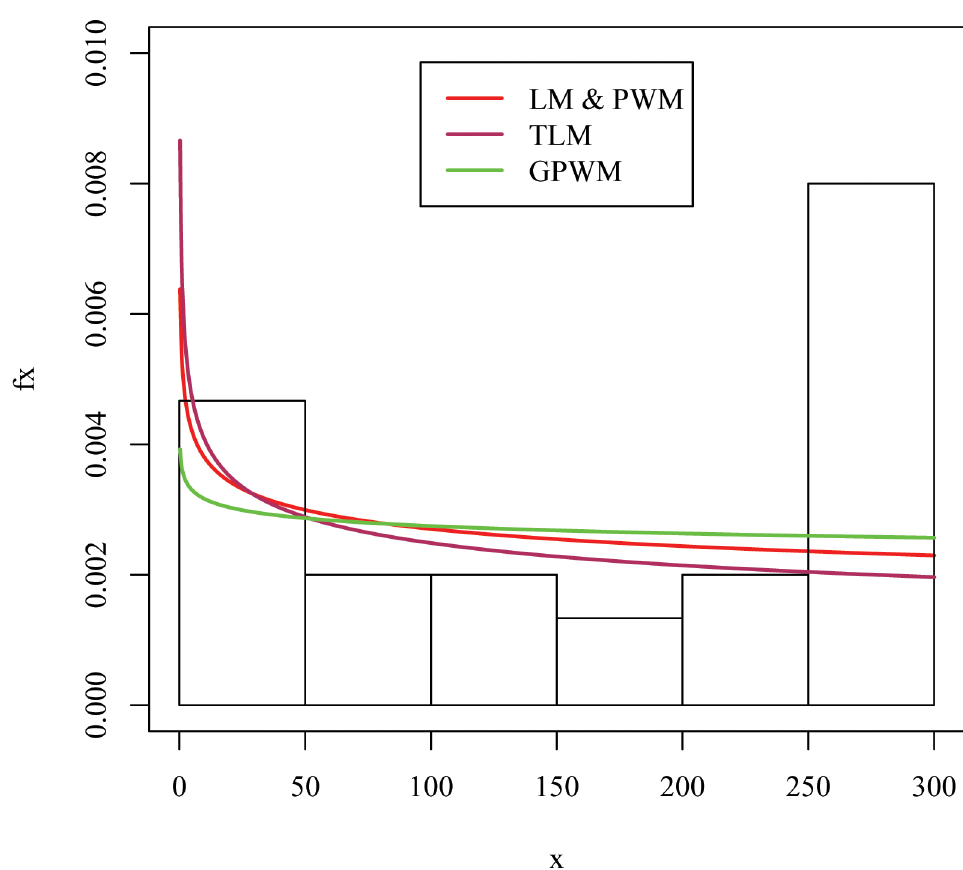
Fig 1. Estimated fitted densities for real data